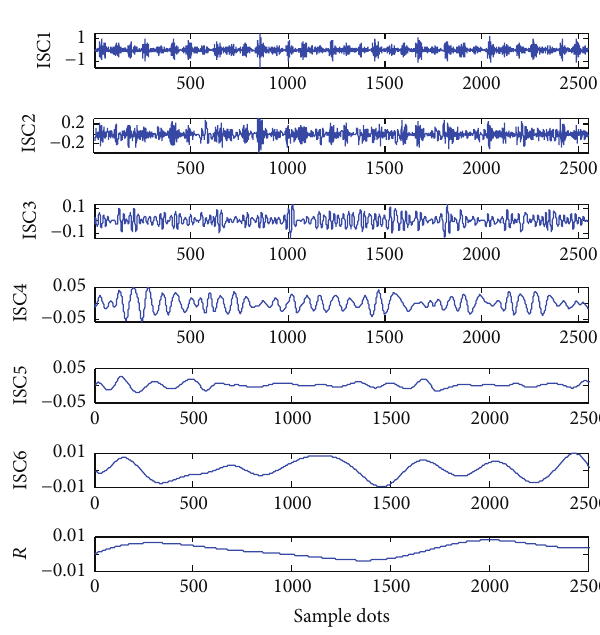
Figure 7: Inner ring fault signal ELCD results. Normal signal